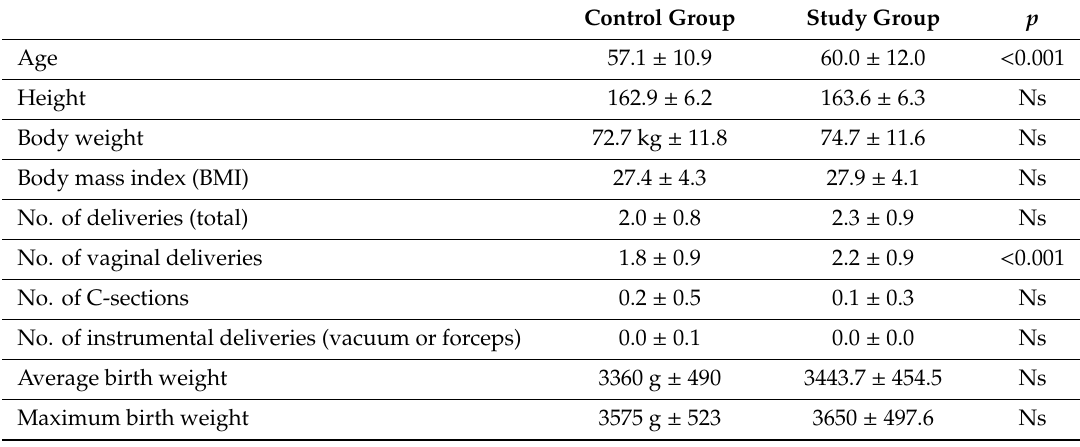
Table 1. Demographic